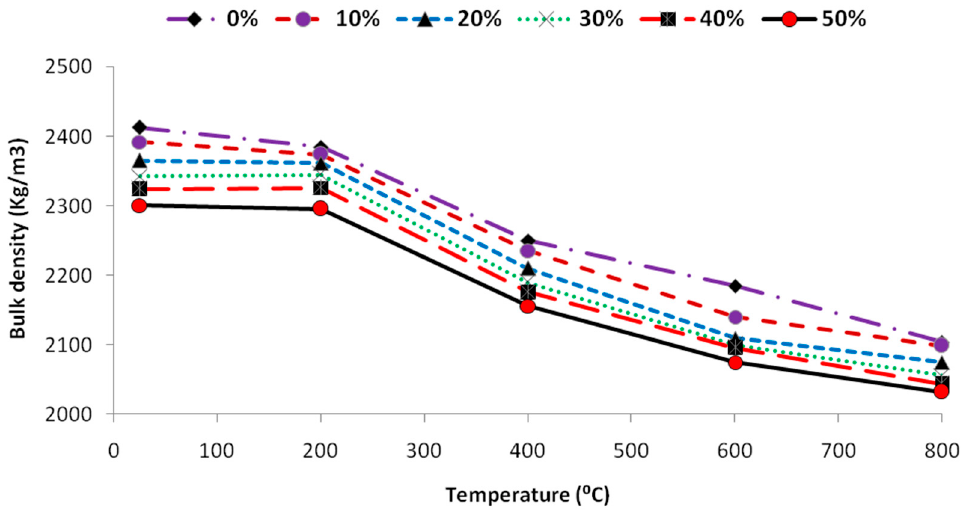
Figure 7. Density variations of SCGM at various temperatures.